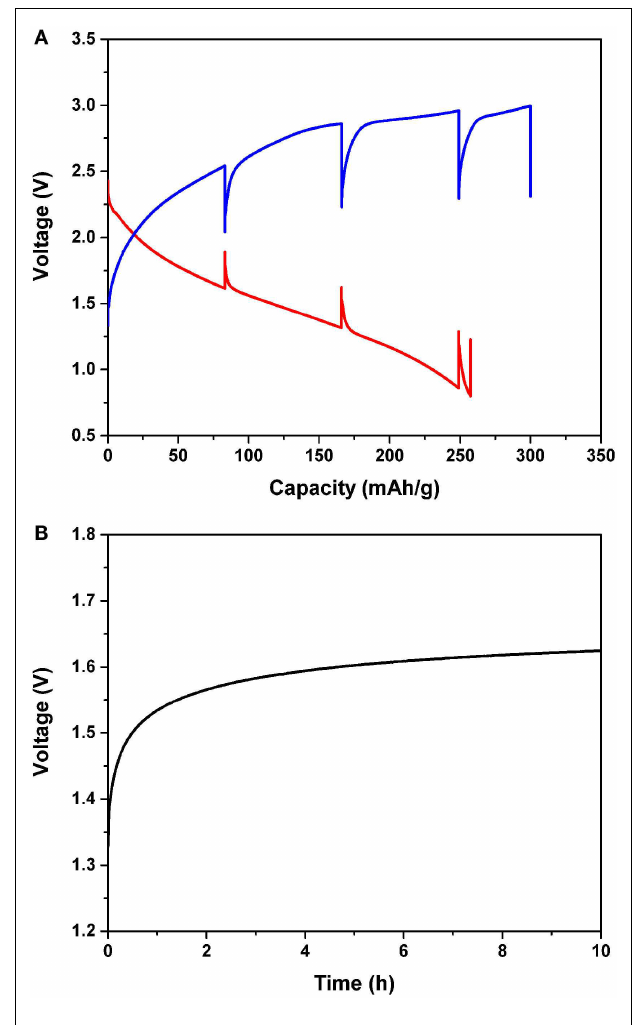
FIGURE 3 | (A) Intermittent magnesiation/de-magnesiation profile of the Mg/MnO 2 cell with the APC electrolyte for the initial cycle, and (B) voltage profile as a function of time.The current density was constantly 0.1mA/cm 2 . Every 7h, the cell was allowed to rest for 10h, as shown in (B) .The cut-off conditions were 0.8 and 2.85V for magnesiation and de-magnesiation,